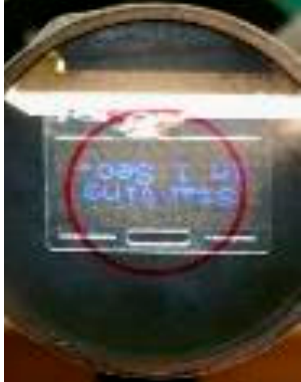
Figure 10. Real image of target in image plane locator.